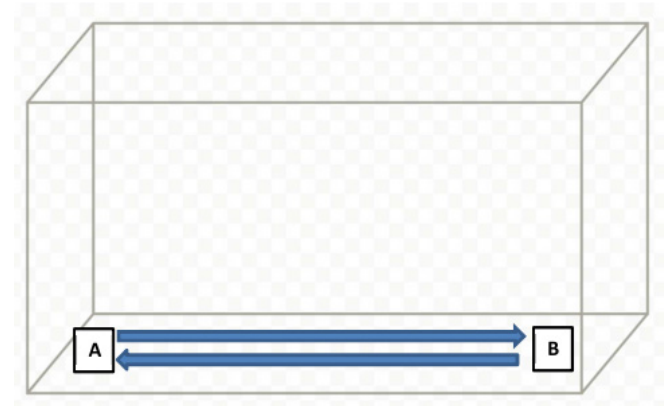
Figure 6. Schematic figure of a home corridor, or a space without furniture. The distance between A and B should be 3 or 4 m.